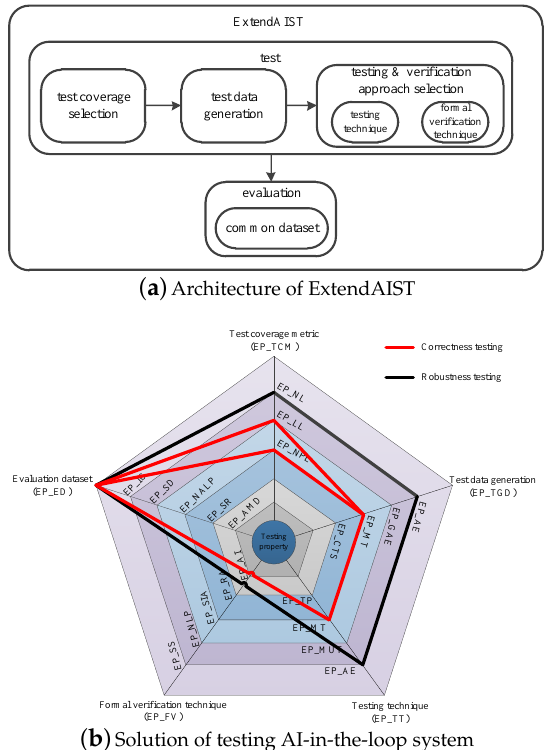
Figure 3. Design of